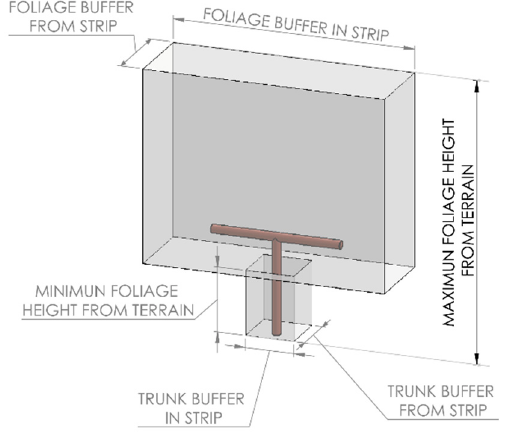
Figure 6. Approximate squared envelope of a vine.